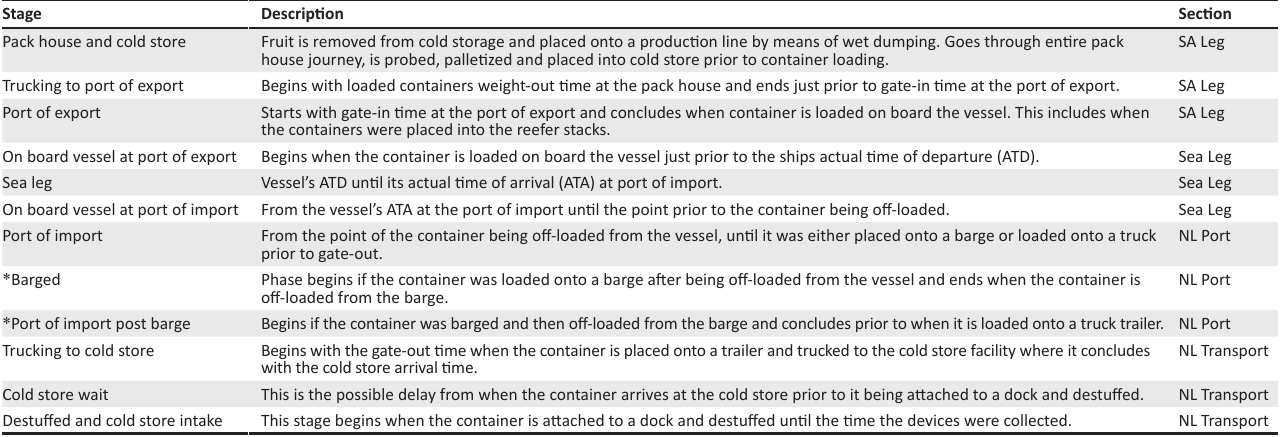
TABLE 1: Pome fruit cold chain stages. Stage Description Section Pack house and cold store